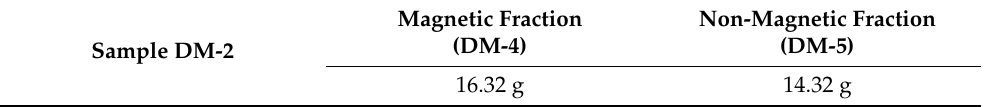
Table 7. Weight split for sample DM-2 after magnetic separation at 0.3